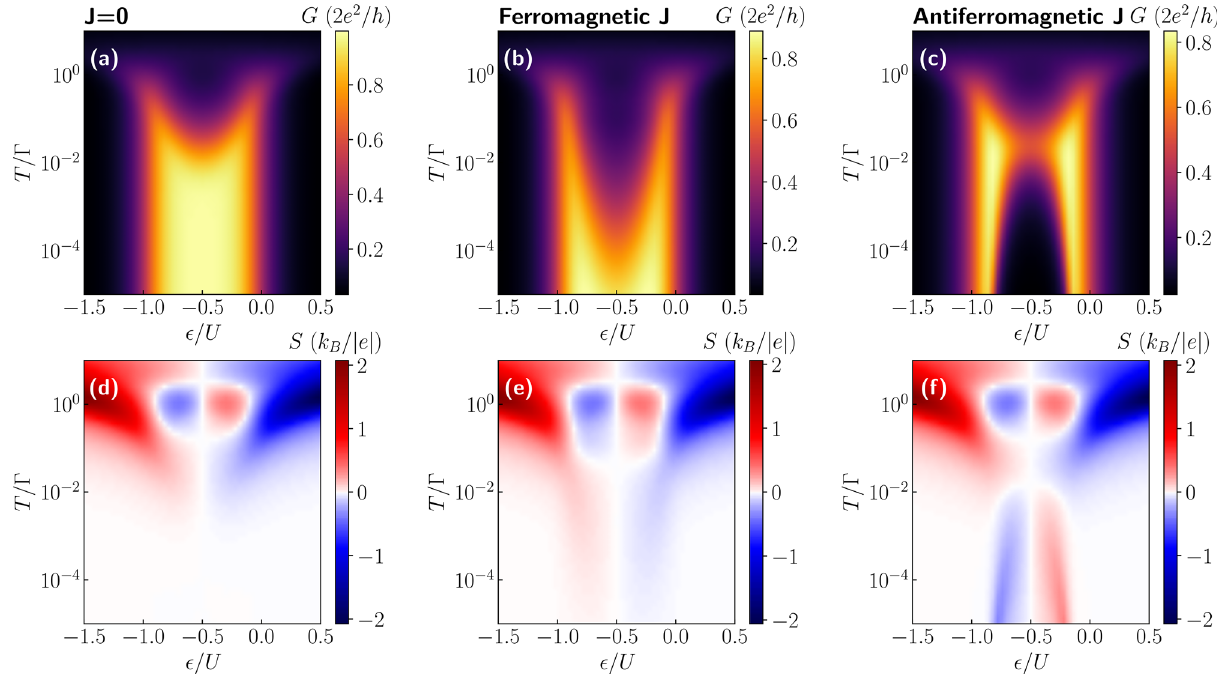
Figure 2. Conductance and thermopower of molecule in nonmagnetic junction. The linear conductance G and thermopower S as a function of the position of molecule’s level ε and temperature T in the case of ( a , d ) J = 0 , ( b , e ) ferromagnetic ( J = 10 T K ) and ( c , f ) antiferromagnetic ( J = − T K ) exchange interaction, where T K = 0.0022 is the Kondo temperature in the case of ε = − U / 2 , J = 0 and p = 0 . The other parameters are: Ŵ = 0.05 , U = 0.5 , D = 0 , in units of band halfwidth, and p = 0 . The spin of the molecule is equal to S = 3 / 2